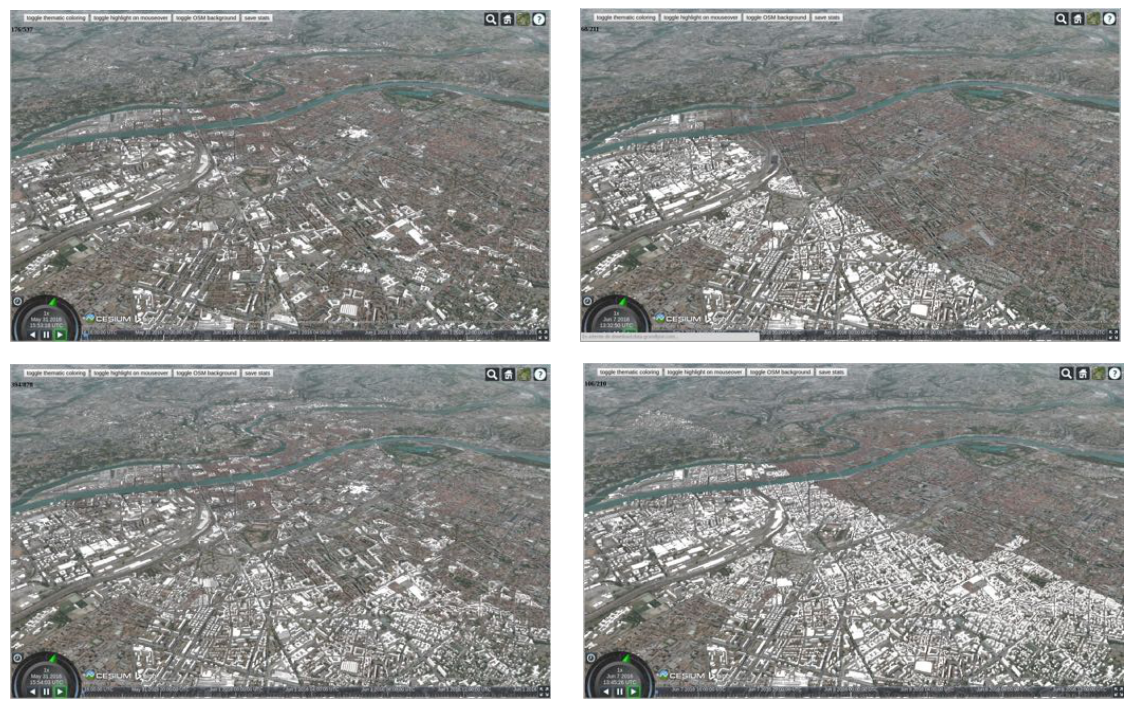
Figure 10: The scene loaded with our method, limited at 500,000 triangles (top left) and 1,000,000 triangles (bottom left). The scene loaded with a grid, limited at 500,000 triangles (top right) and 1,000,000 triangles (bottom right). or removing features is fast, a few milliseconds, compared to the time it takes to create the hierarchy, which takes seconds.